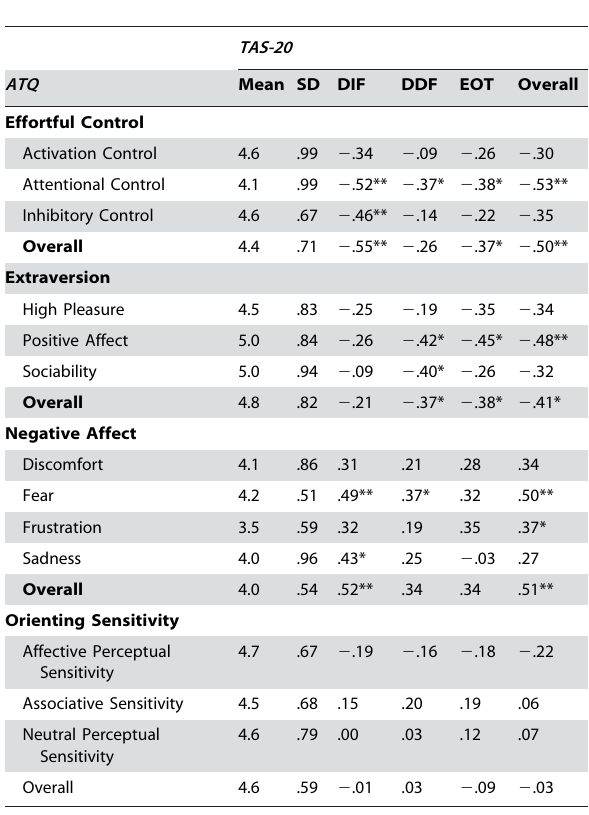
Table 3. Means and SDs of ATQ, and correlations between TAS-20 and ATQ